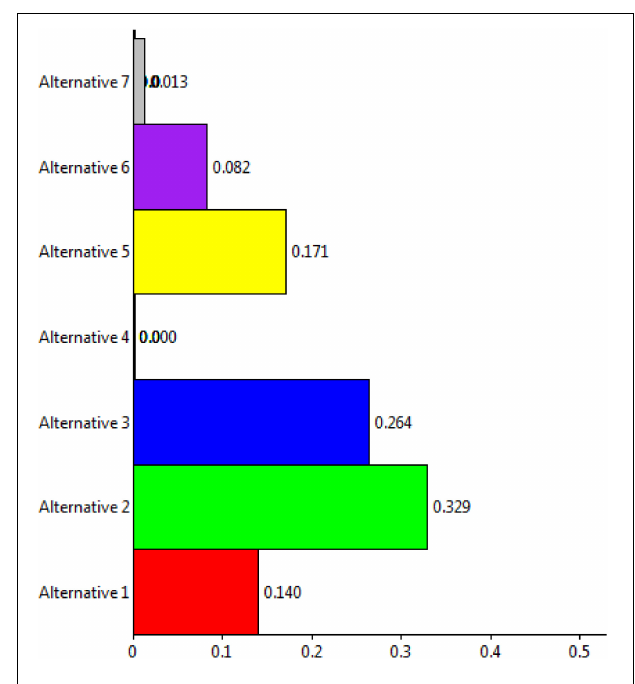
FIGURE 8 | Alternative 3. FIGURE 9 | Alternative